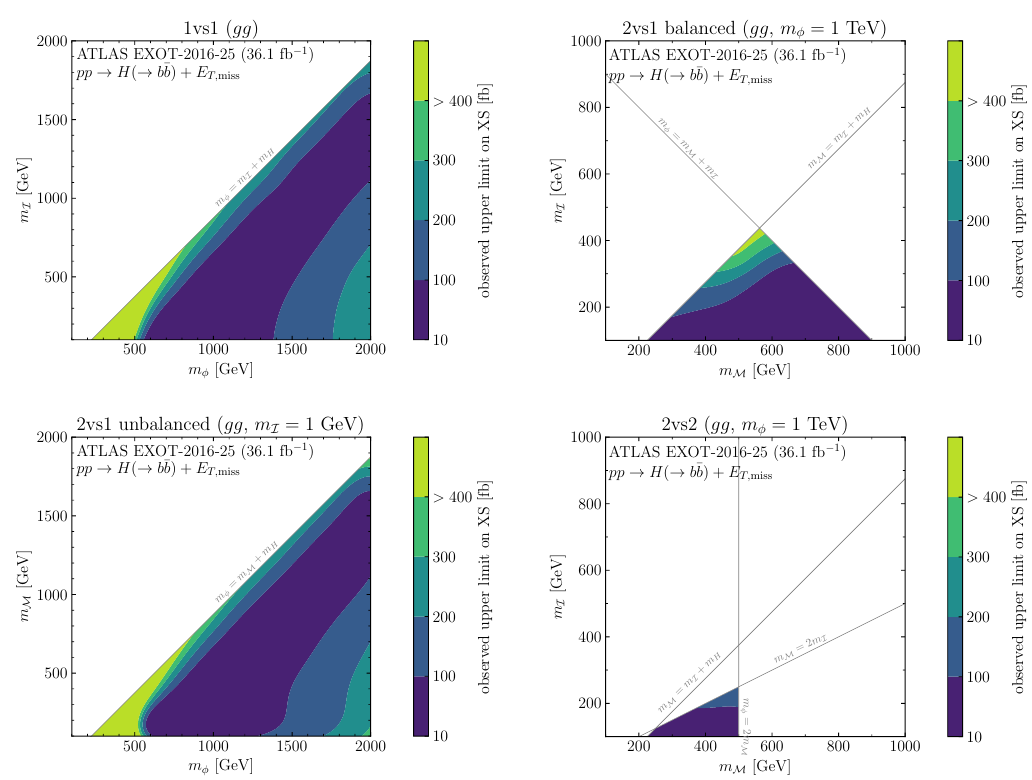
Figure 17. 95% CL upper limits, derived by recasting the ATLAS mono-Higgs plus E miss